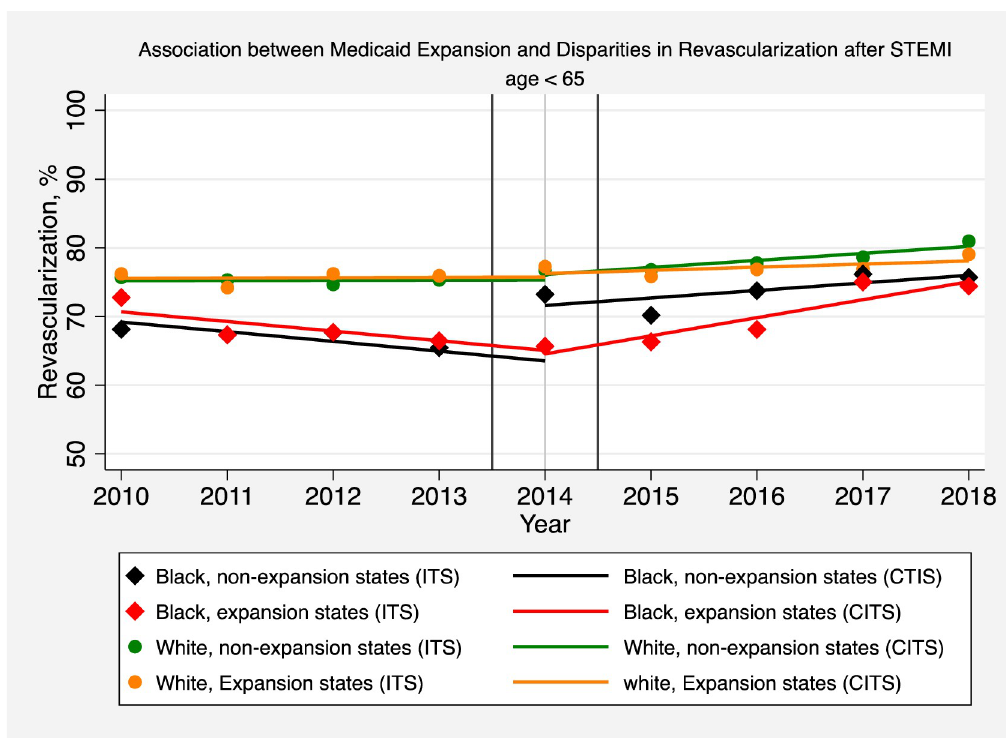
Fig 3. Association between medicaid expansion and disparities in revascularization after STEMI (age < 65). The solid symbols represent the yearly estimates for the revascularization rate in patients hospitalized with a STEMI in non-expansion states and expansion states, respectively, based on an interrupted time series (ITS) model after adjusting patient-level and hospital effects, without imposing restrictions on time trends and making no assumptions that time effects were different before or after 2014. The solid lines are based instead on a comparative interrupted time-series (CITS) model which assumes that pre-intervention and post-intervention trends are linear in order to interpret changes in revascularization rates before and after Medicaid